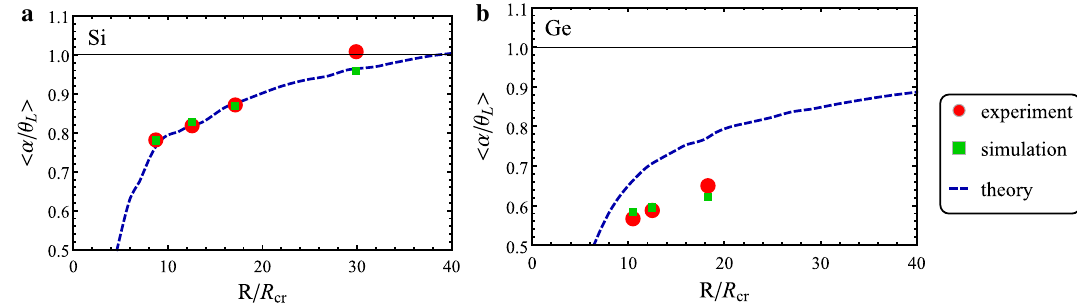
Fig. 10 Theoretical, experimental and simulated dependence of the maximal value of volume reflection peak position w.r.t. the Lindhard angle on the bending radius w.r.t. its critical value for both Si and Ge (111) bent